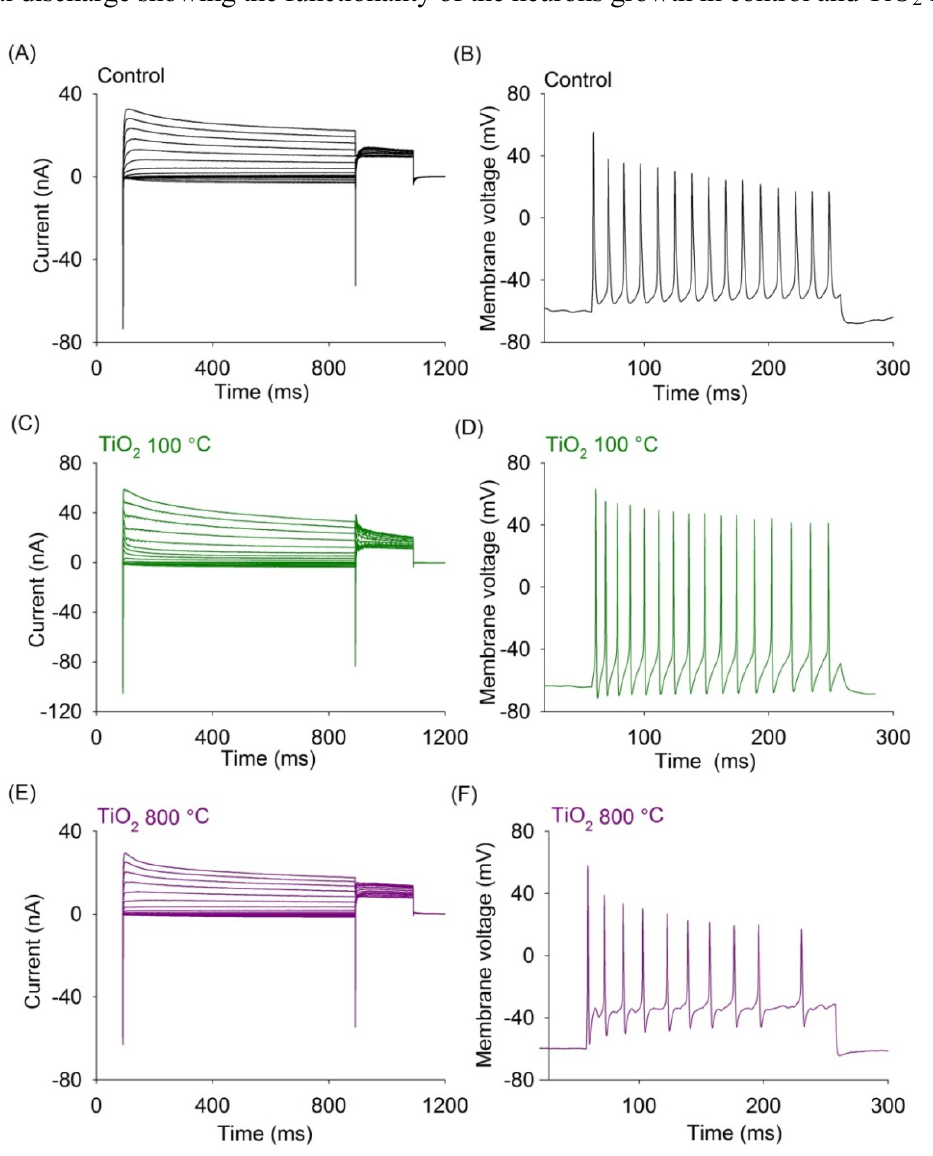
Figure 2. Representative membrane ionic currents and membrane voltage response of DRG neurons cultured in control substrate and TiO thin films surfaces. ( A , C , E ) ionic currents 2 generated with an 800 ms pulse (from − 110 to +40 mV) followed by 200 ms test pulses to = − 60 mV). Neurons grown on control glass surface and those grown on TiO 0 mV ( V H 2 films annealed at 100 and 800 °C showed similar set of currents with an initial rapid inward current followed by a slowly inactivating outward current; ( B , D , F ) representative voltage = − 60 mV) of DRG responses to current pulse injection (100, 400 and 300 pA, and V m neurons cultured in control substrate and TiO thin films annealed at 100 and 800 °C. 2 Recordings of the voltage response of neurons to a current pulse showed typical action potential discharge showing the functionality of the neurons growth in control and TiO 2